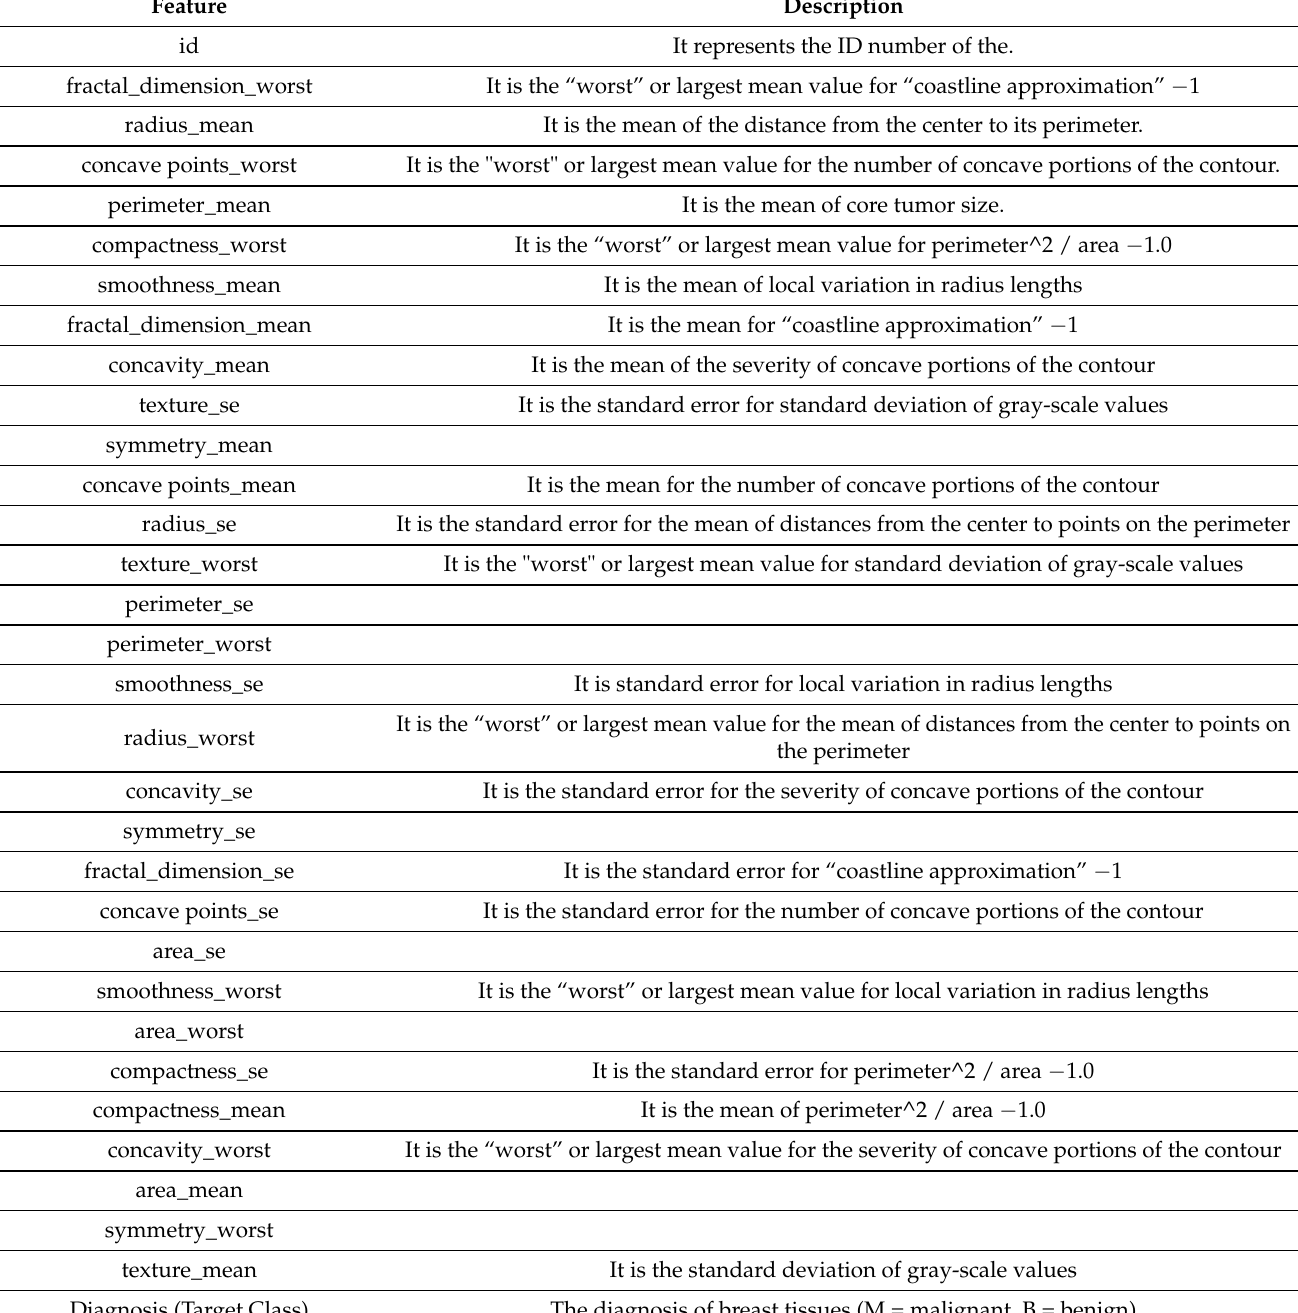
Table 2. Dataset features and their